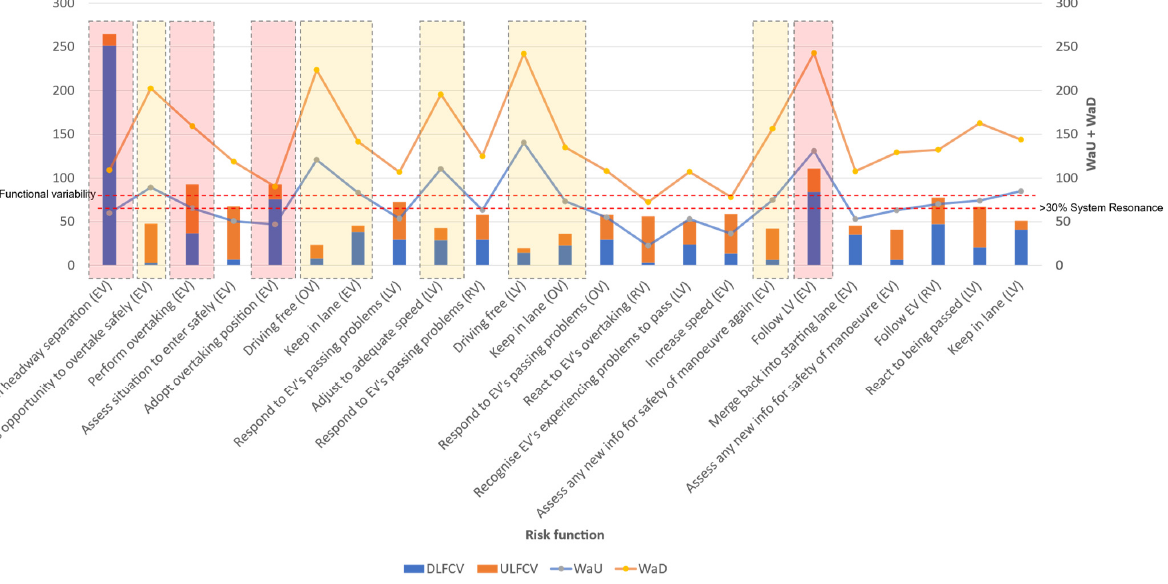
Figure 12. Risk functions for automation composed of functional variability and system resonance. Compared to the automation in Figure 12, it can be seen that humans have signifi- cantly lower variability values and that overall, significantly more risk functions in auto- mation have high functional variability. However, the values of the system resonance are slightly higher for the human risk functions than for automation ones. Several risk functions are also colour-coded in the automation (see Figure 12). This results in seven critical functions (red), with < observe oncoming traffic (EV) > standing out. Conspicuous compared to the human driver is the distribution of critical functions among the function types: five cognitive tasks, one perceptual task, and only two action tasks. Furthermore, four risk functions can be identified as success factors (orange), for example < follow LV (EV) > and < keep in lane (LV) >, each with high systemic resonance